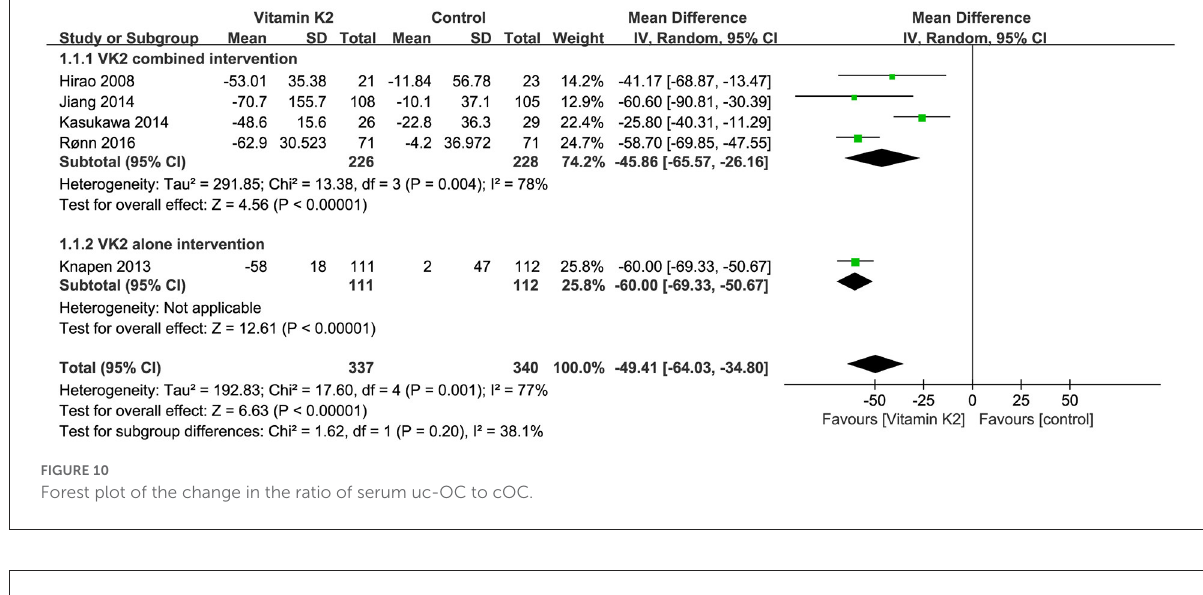
FIGURE10 Forest plot of the change in the ratio of serum uc-OC to cOC.